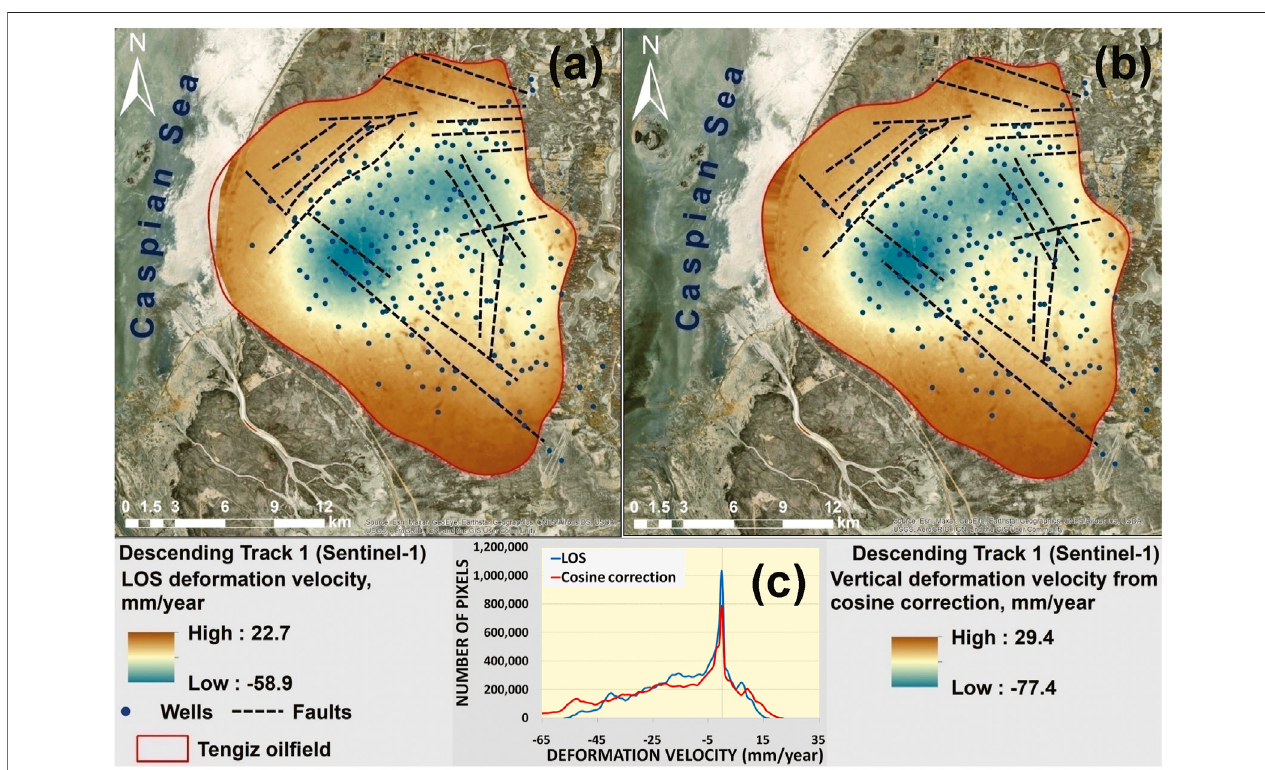
FIGURE 5 | (A) LOS and (B) vertical displacement velocity from cosine correction of the Tengiz oil fi eld; (C) Histogram of LOS and vertical displacement velocity.